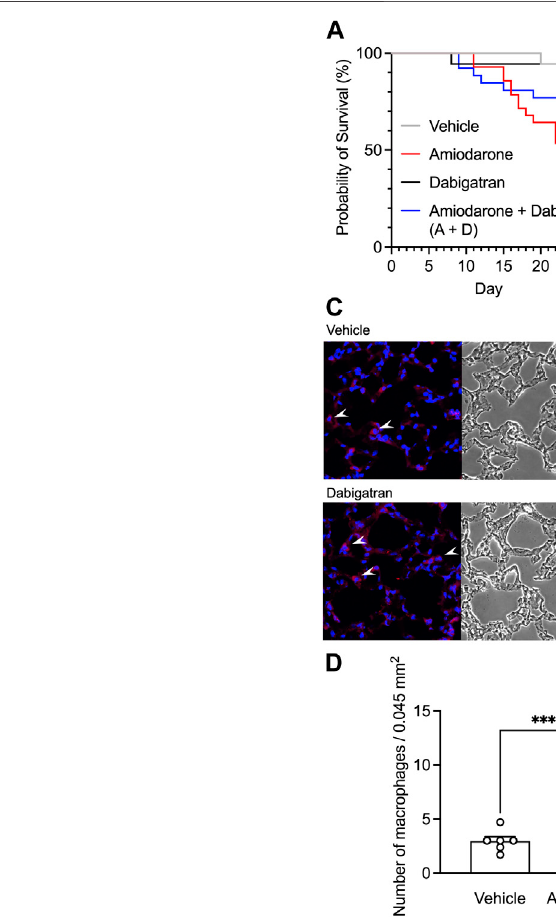
Frontiers in Pharmacology |